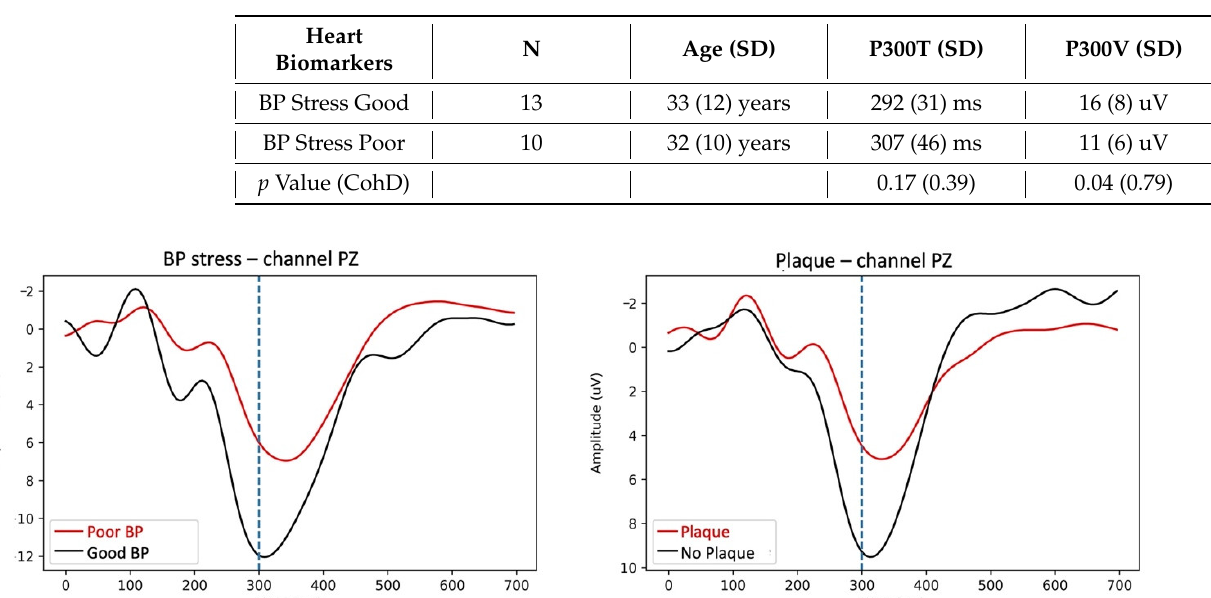
Figure 5. The percentage of patients in this study showing Poor BPS vs. Good BPS and Plaque vs. No Plaque (as per Table 1) as a function of age. Table 4. Differences in P300 between younger subjects classified as good versus poor blood pressure measures. Bold values represent significant differences, p < 0.05, and large effect sizes, Cohen’s D > 0.55.